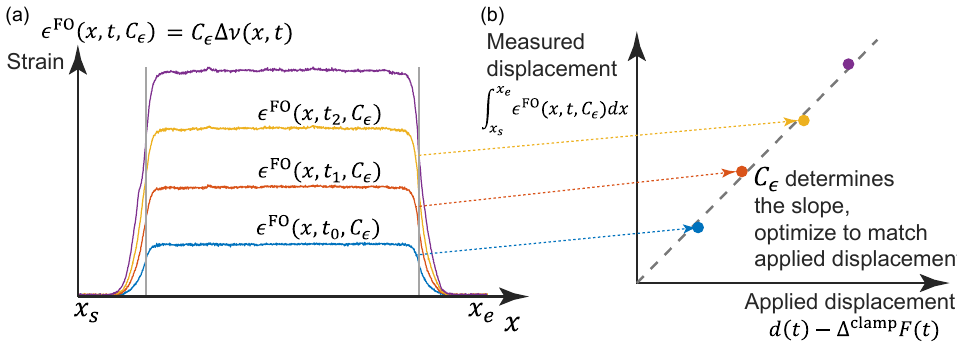
Figure 4. Illustration of the fiber optic cable calibration: ( a ) Strain distributions under different displacement levels (by different colors); ( b ) calibration of C (cid:101) by matching the applied displacements.